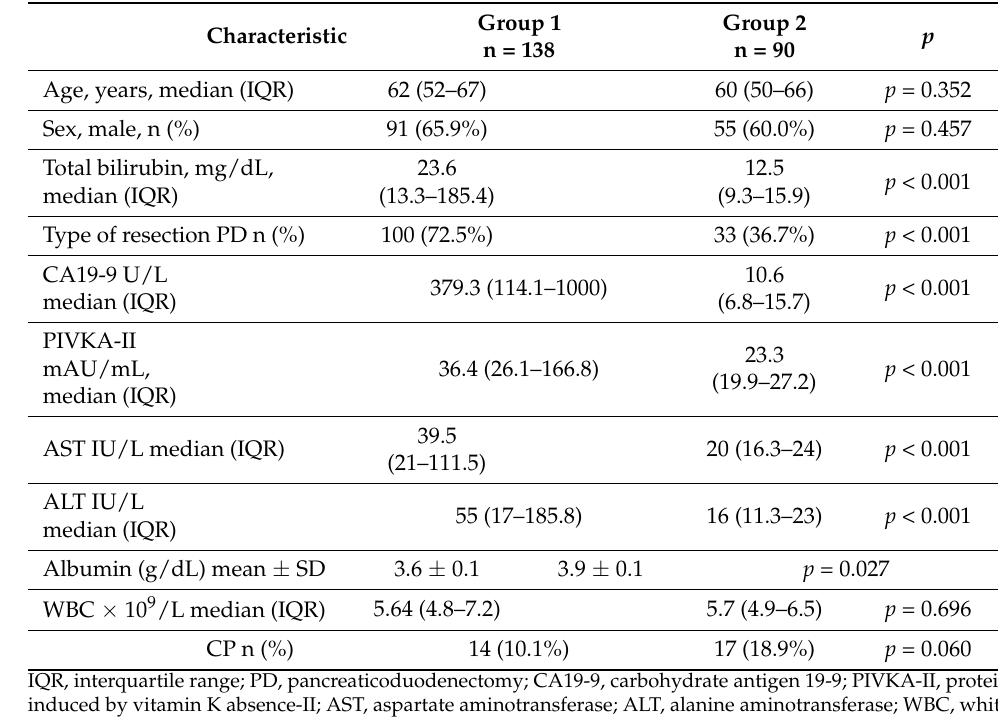
Table 1. Clinical characteristics of the patients.